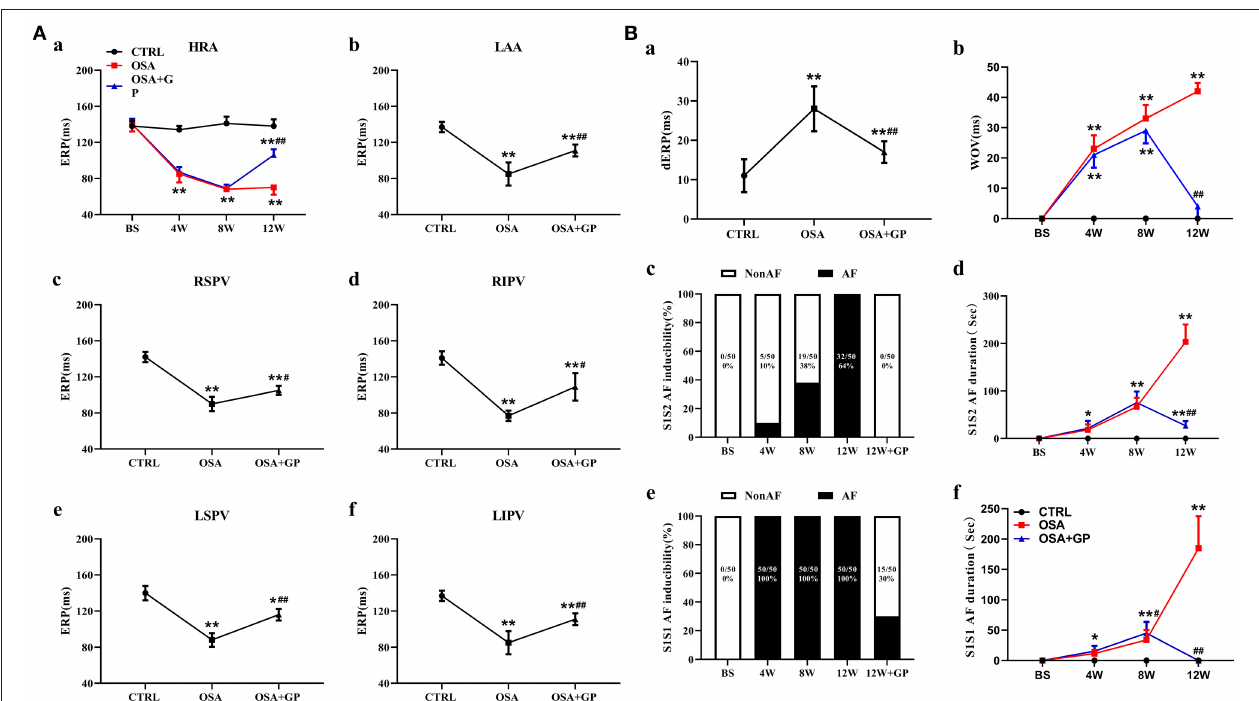
FIGURE 3 | Effect of SLGP ablation on electrical remodeling. (A) Change in the mean ERP at different paced sites among the three groups (a–f). (B) Change in dERP (a) and WOV (b) among the three groups. The mean value of AF duration and AF inducibility (atrial tachyarrhythmia ≥ 5s) after 10 S1–S2 pacing (c, d) and burst